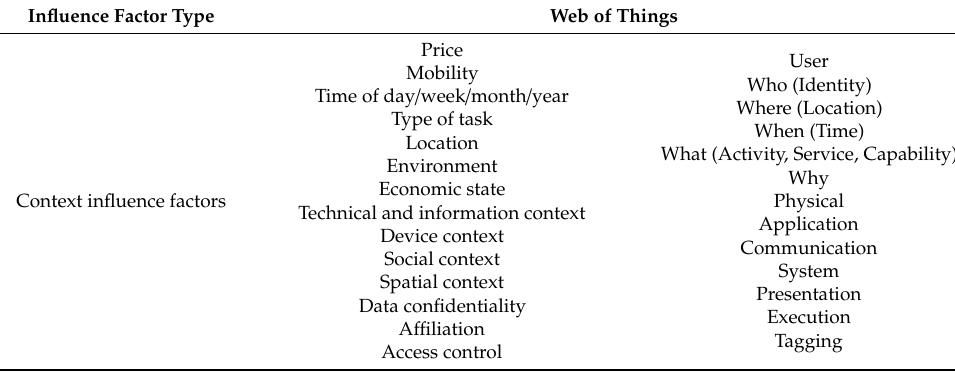
Table 2. List of influence factors to be considered when addressing security perception in WoT context with the aim of improving QoE and